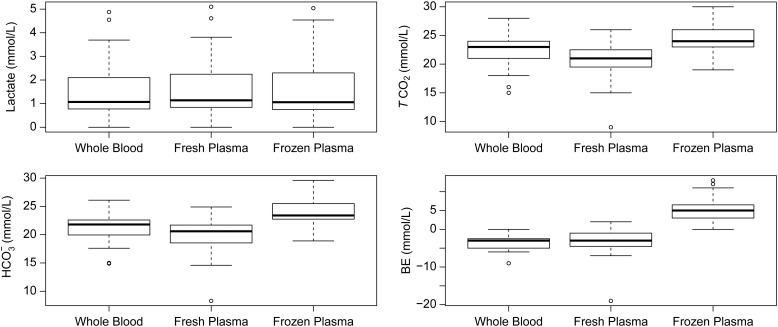
Box plots for lactate, total carbon dioxide (TCO2), bicarbonate (HCO3−) and base excess (BE) concentrations in American alligator (Alligator mississippiensis) whole blood, fresh plasma and frozen plasma samples.